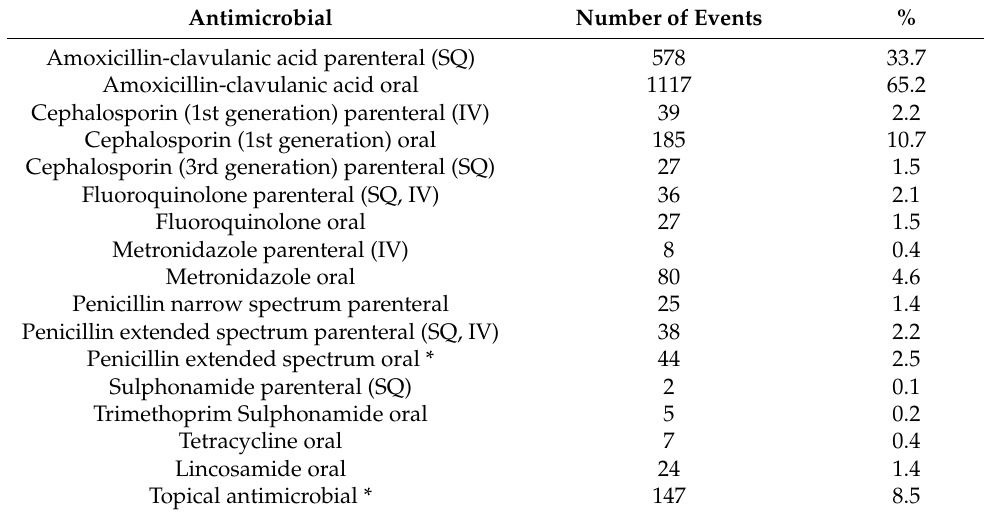
Table 2. Number of events prescribed antimicrobials and route of administration in dogs which presented for treatment of dog-to-dog bite wounds from 1998 to 2018.